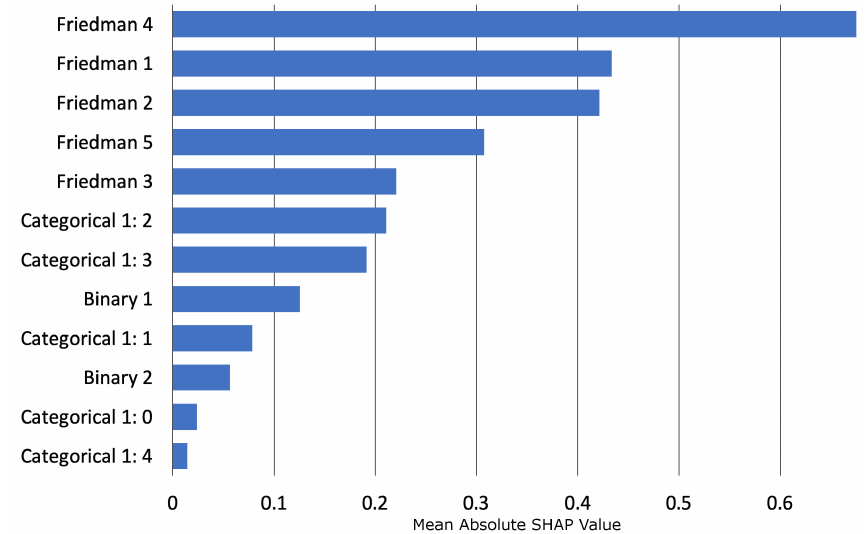
Figure A2. Global mean absolute Tree SHAP feature importance for g MGBM ( X ) on the simulated test data.